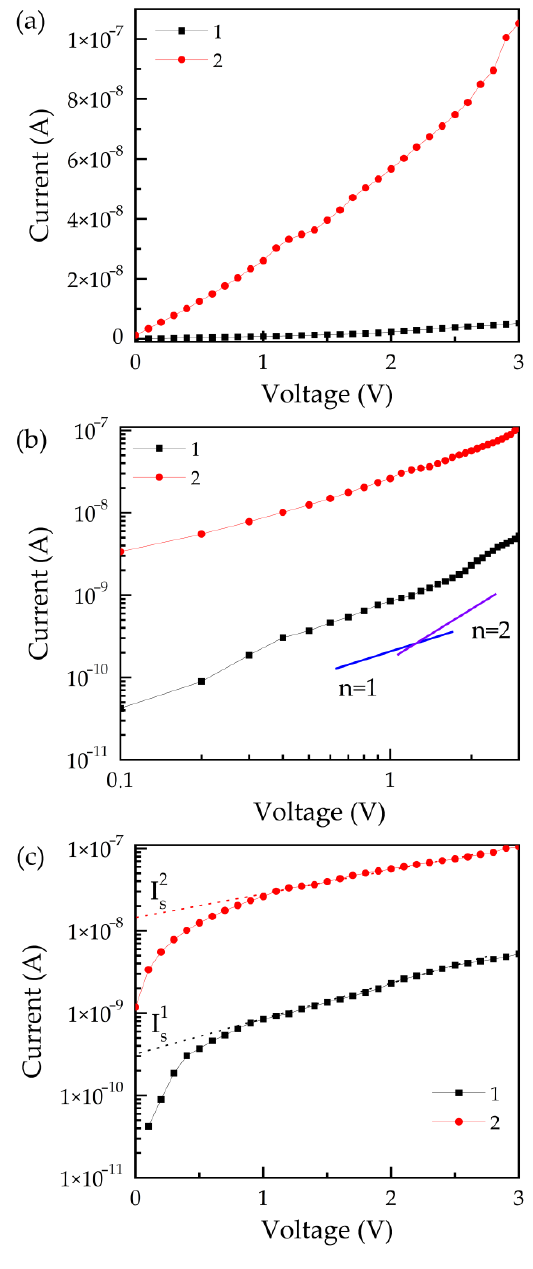
Figure 4. ( a ) Volt-ampere characteristics measured along the interface of polymer films, ( b ) in semi-logarithmic and ( c ) logarithmic coordinates. 1 — PDPh – PDPh, 2 — PDPh – Cu 2 O – PDPh. I s 1,2 —are the saturation currents for doped and non-doped samples.